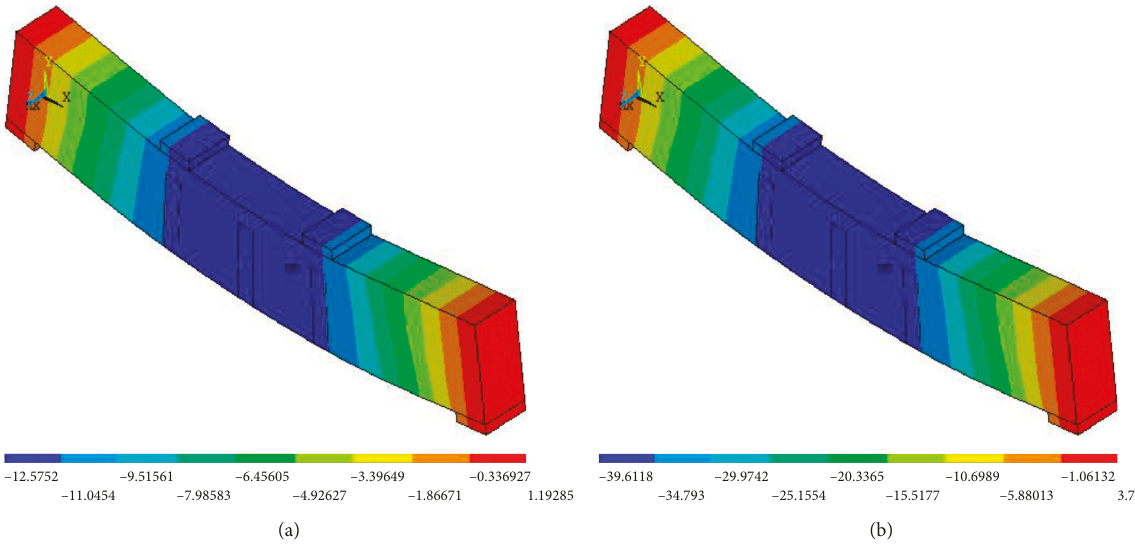
Figure 12: 3D views of deflections in the B4 model at (a) the yield load stage and (b) the maximum load stage.